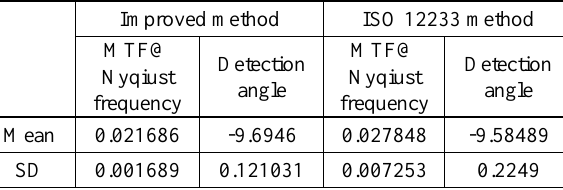
Table 6. The estimated MTF of GF-1 panchromatic image (Along-track, SNR of MTF=68)